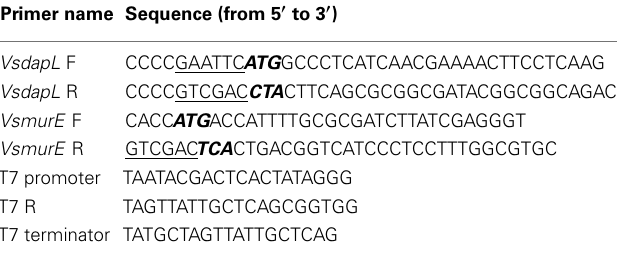
Table 4 | List of Primers used for PCR amplification, cloning and nucleotide